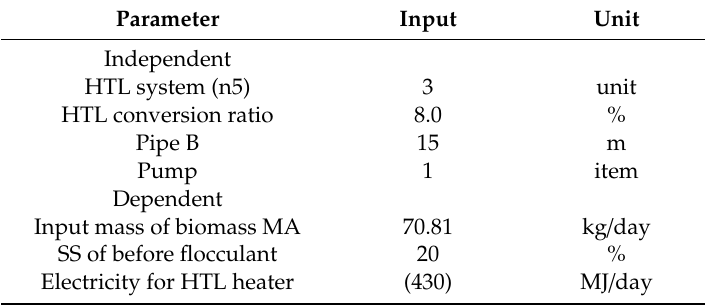
Figure 10. Mass balance of microalgae oil production in HTL sub-unit per 1 m 3 . Table 8. Parameters set at extraction (HTL) sub-unit per 50 m 3 /